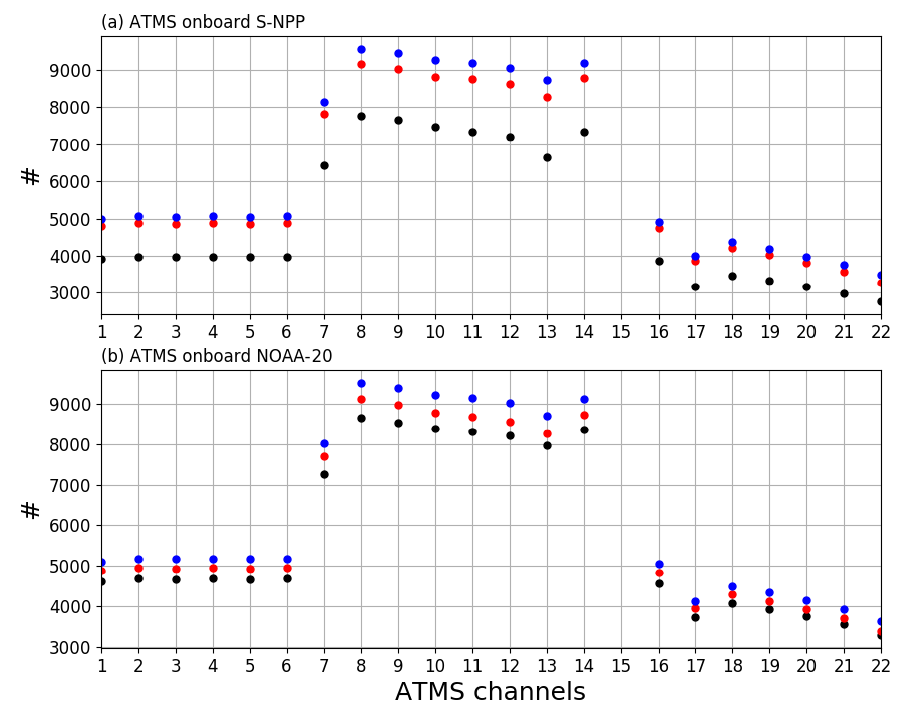
Figure 6. The spectral distribution of mean assimilated data number of ATMS channels onboard ( a ) S-NPP and ( b ) NOAA–20 satellites for three trial runs for the period from 7 July to 22 August 2018. Black, red, and blue circles indicate the control, latency_20m, and latency_5m runs, respectively.